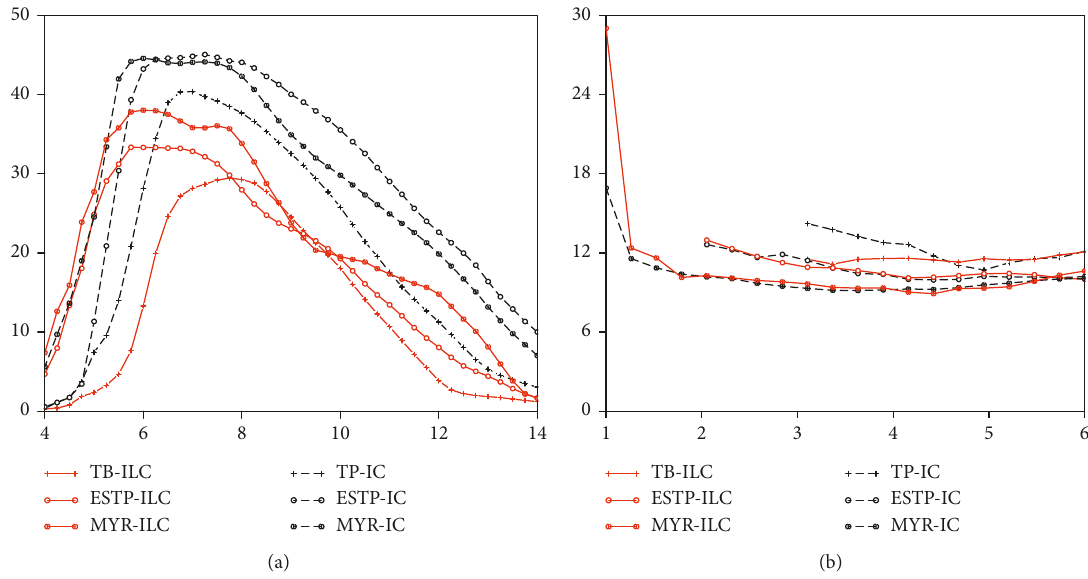
Figure 12: The vertical distribution of the average effective radius of different hydrometer particles corresponding to different types of TPV category cloud clusters in each key region: (a) effective radius of ice crystal particles; (b) effective radius of water-droplet particles ((a) ice crystals, (b) cloud droplets, the red legend represents the ice-water mixed-phase type, the black legend represents the pure ice phase type, X - axis represents altitude (unit: km), and Y -axis represents average effective radius (unit: μ